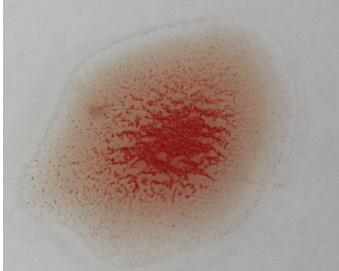
Figure 20. The additional reference agglutination image used in matching to optimize ORB results.